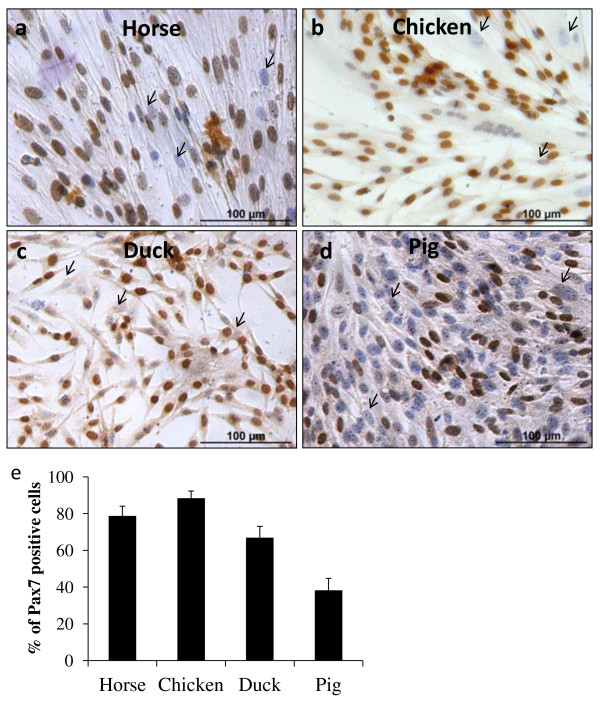
Pax7 expression appears to be exclusively confined to myoblasts of horse, chicken, duck and pig. The percentage of satellite cells was determined in primary muscle cultures by immunocytochemistry for the muscle-specific transcription factor Pax7. Representative fields of equine (biceps femoris) (a), chicken (pectoralis major) (b), duck (pectoralis major) (c) and porcine (psoas major) (d) cells at an early stage of differentiation are shown. Arrows show cells which were negative for Pax7. Haematoxylin counterstaining was used. Each species analysed presented a significantly different percentage of Pax7 positive cells (p < 0.001) (e) with chicken displaying the highest number (≈90%), followed by horse (≈80%), duck (≈70%) and pig (≈40%). The results were evaluated using a pairwise t test. Graph shows the mean percentage of Pax7 positive cells with standard deviation.